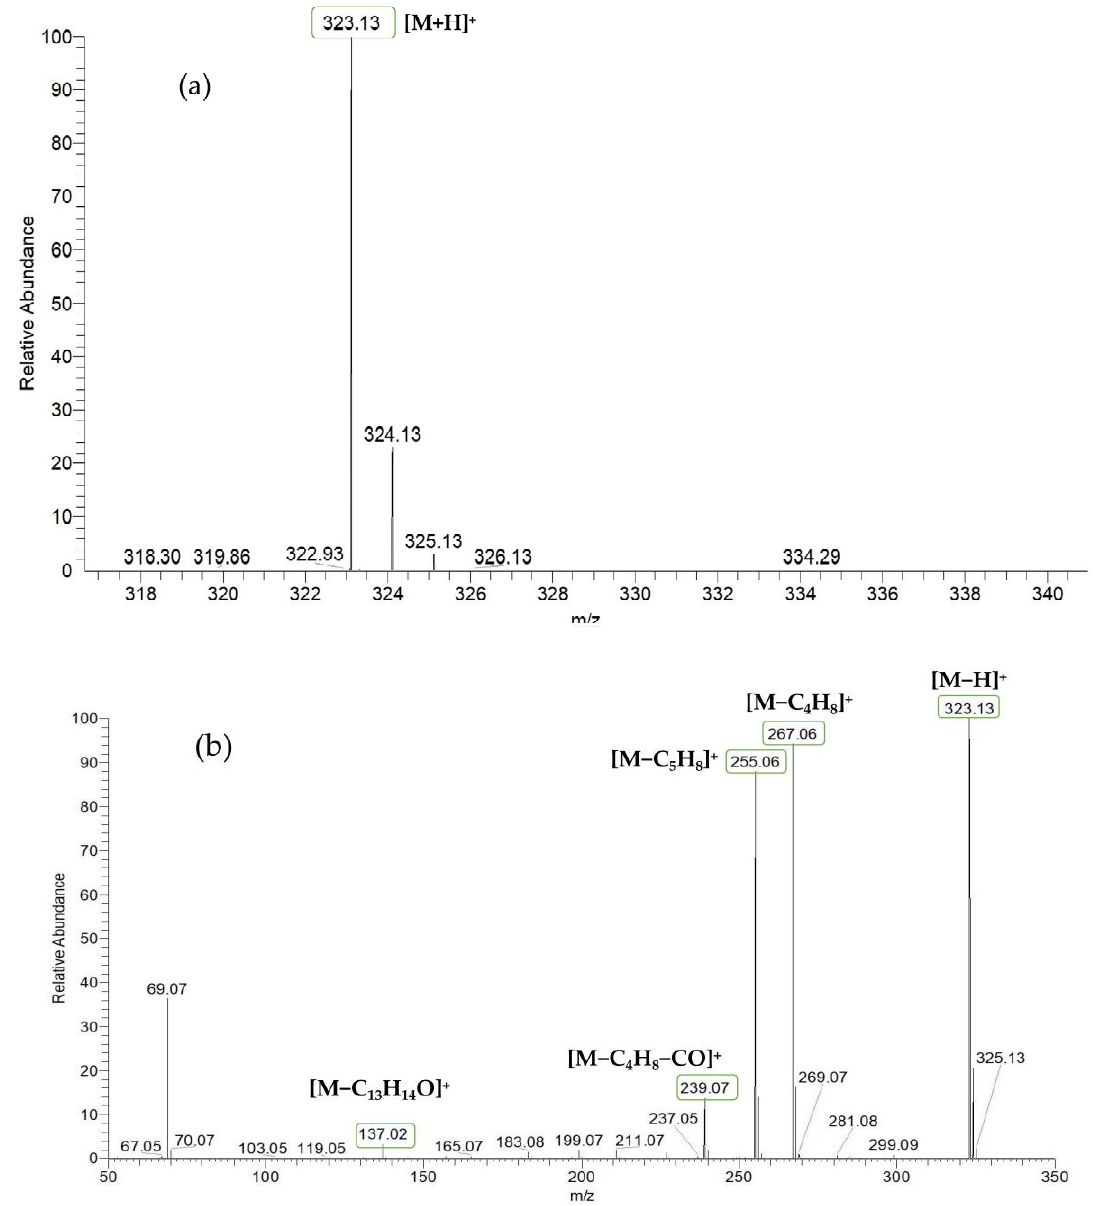
Figure 2. The MS ( a ), and MS 2 ( b ) spectra of neobavaisoflavone in the positive ion mode.